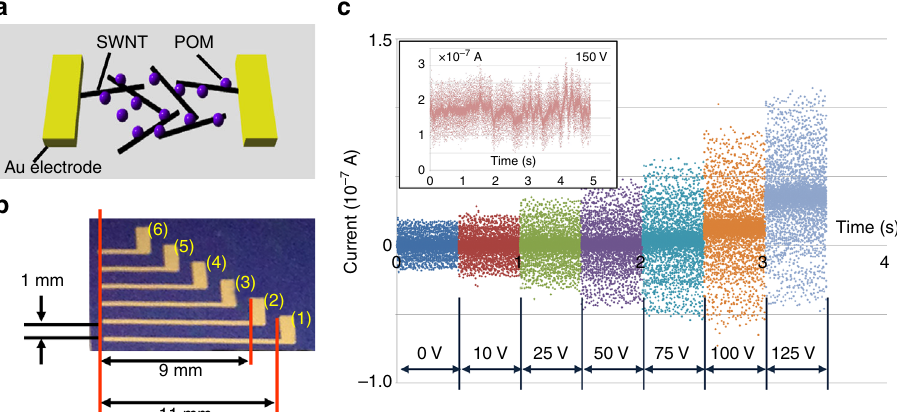
Fig. 2 Experimental setup and noise generation of the SWNT/POM network. a Schematic of a network with the SWNT/POM complex network. The yellow cuboids, black tubes and purple spheres represent the terminal electrodes, SWNTs and POM particles, respectively. b Photograph of the substrate including six terminal electrodes. The entire substrate was covered with the SWNT/POM complex. c Sampled current density over time, representing the current magnitude distributions, with the bias voltage V B increasing stepwise across the electrodes from 0 to 125 V for sample